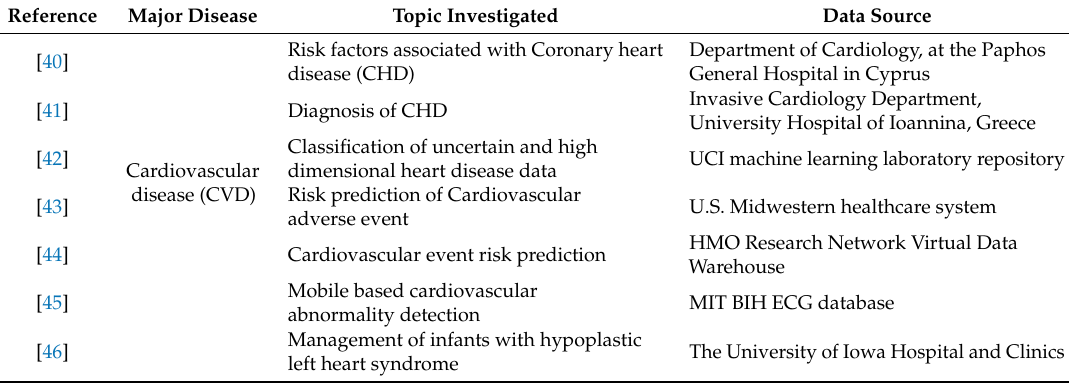
Table 5. Topics and data sources of papers using clinical decision-making, organized by major disease category.